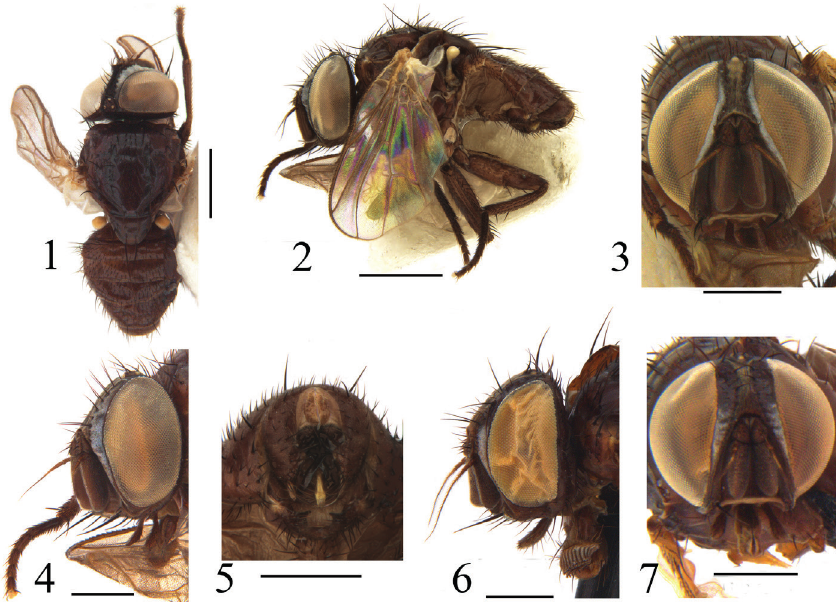
Figures 1-7 - Fannia capitalis Pont 1977: 1 . Adult male, dorsal view; 2 . Adult male, lateral view; 3 . Adult male, head frontal view; 4 . Adult male, head lateral view; 5 . Adult male, apical portion of abdomen and terminalia, ventral view; 6 . Adult female, head frontal view; 7 . Adult female, head lateral view. Scale bars = 0.5